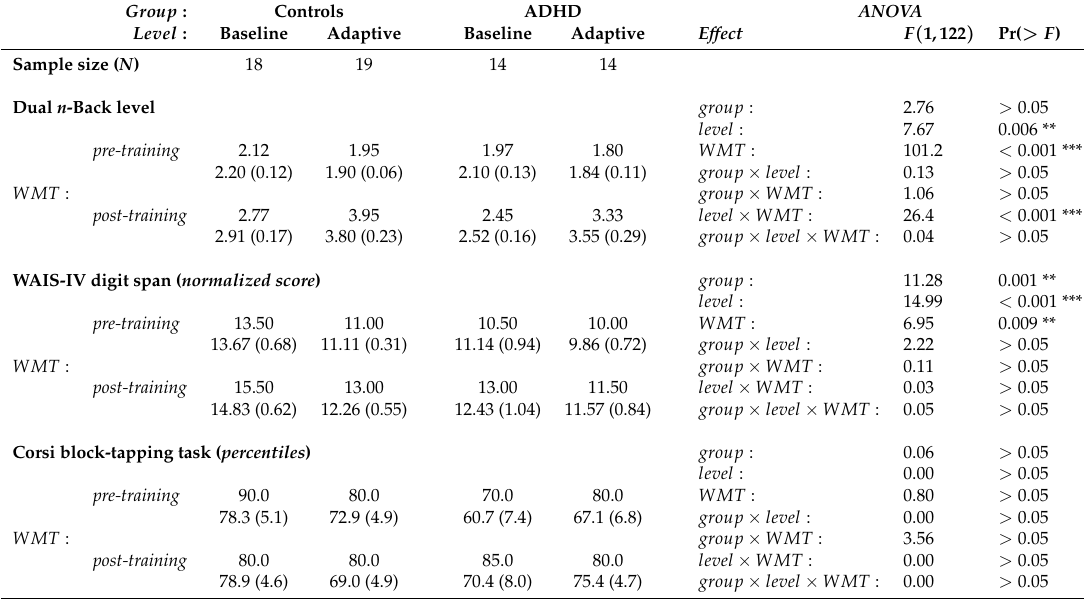
Table 1. Pre and post-training performance (median, mean, and SEM)to the memory tasks and results of the three-way analysis of variance